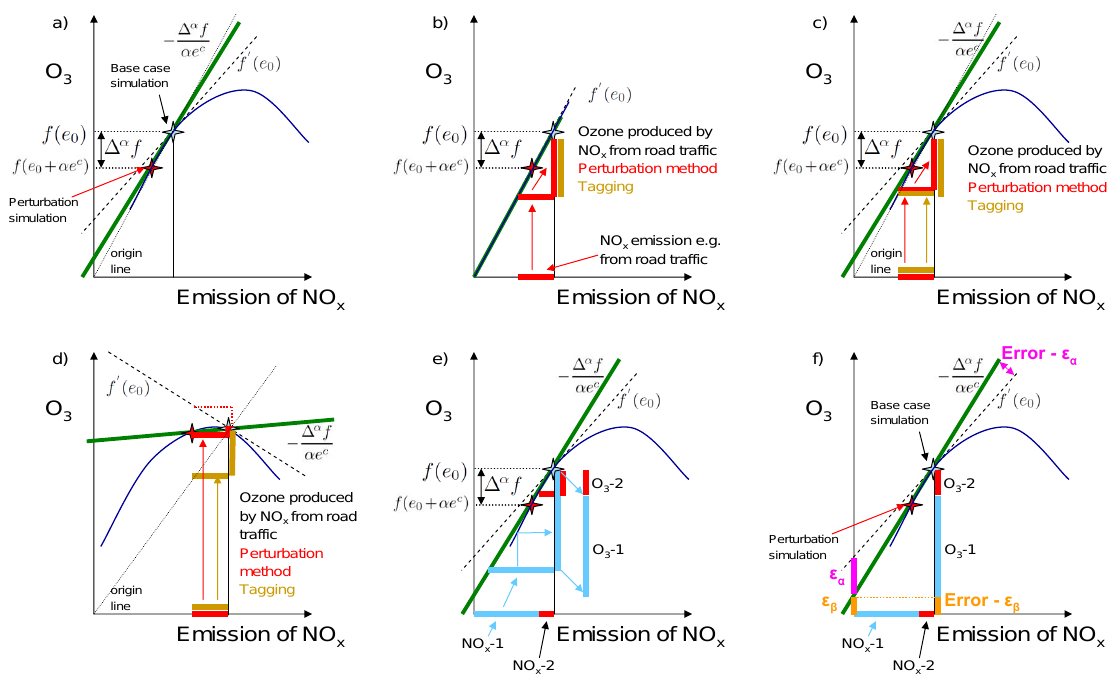
Fig. 1. Illustration of the sensitivity method (pair of simulations) to derive contributions from emission categories and intercomparison with the tagging method. The ozone concentration in arbitrary units is shown as a function of the emission of NO x . Two simulations (base case and a simulation in which the emissions e c is changed by a factor α ) are indicated with stars. The derivative is added as a tangent for the base case (dashed line). The line through the base case simulation and the origin (origin line) is dotted. The green line shows the estimated derivative, based on the two simulations. (a) General settings and calculation of the derivative. (b) Assumption of linearity in ozone chemistry for illustration purpose. An arbitrary NO x emission (horizontal red line) is considered. The vertical red and brown lines indicate the ozone contributions caused by this NO x source (sensitivity method in red and tagging in brown) giving identical results. (c) As (b) but for the assumption of a non-linear ozone chemistry, however in a situation, which is close to the linear case. The green and dotted lines are used to calculate the contributions based on the sensitivity and tagging method, respectively. (d) As (c), but for a situation, which is far from the linear regime. (e) Calculation of the ozone contributions; two emission categories are considered (NO x -1: light blue, NO x -2: red) and the ozone contributions O 3 -1 and O 3 -2 indicated with vertical lines. (f) Error analysis; the two errors (cid:15) α (magenta) and (cid:15) β (orange), which describe uncertainties associated with the determination of the tangent and the total estimate of all contributions (intersection of y-axis and tangent) (see Sect. 6). Note, the origin line for tagging represents the equality of all emitted NO x molecules to take part in a reaction, which implies that a subset of NO x molecules, e.g. from the sources category “road traffic”, produces a sub-set of ozone molecules in a linear relation-ship (=origin line) for a non-linear chemistry (blue